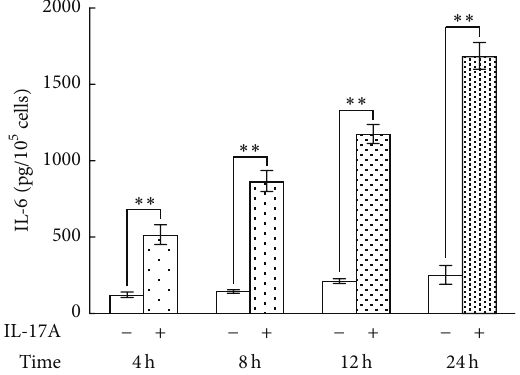
Figure 6: Time course of IL-17A-induced IL-6 production by synovial fibroblasts. Synovial fibroblasts were treated with 10ng/mL IL-17A for 4, 8, 12, or 24 h. The IL-6 protein levels in the conditioned medium were then assayed using ELISA. Data are shown as means ± SD ( 𝑛 = 6 ); ∗∗ 𝑃 < 0.01